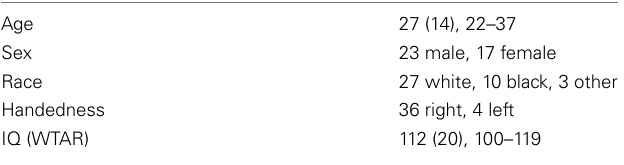
Table 1 | Participant demographics for the sample of